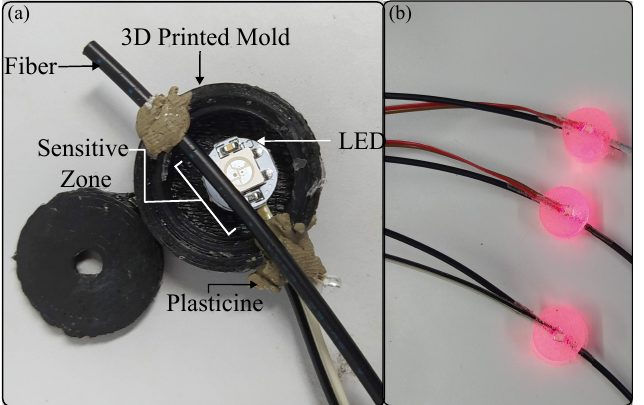
Figure 6. Construction of the contact force sensor. ( a ) 3D-printed mold. ( b ) Contact force